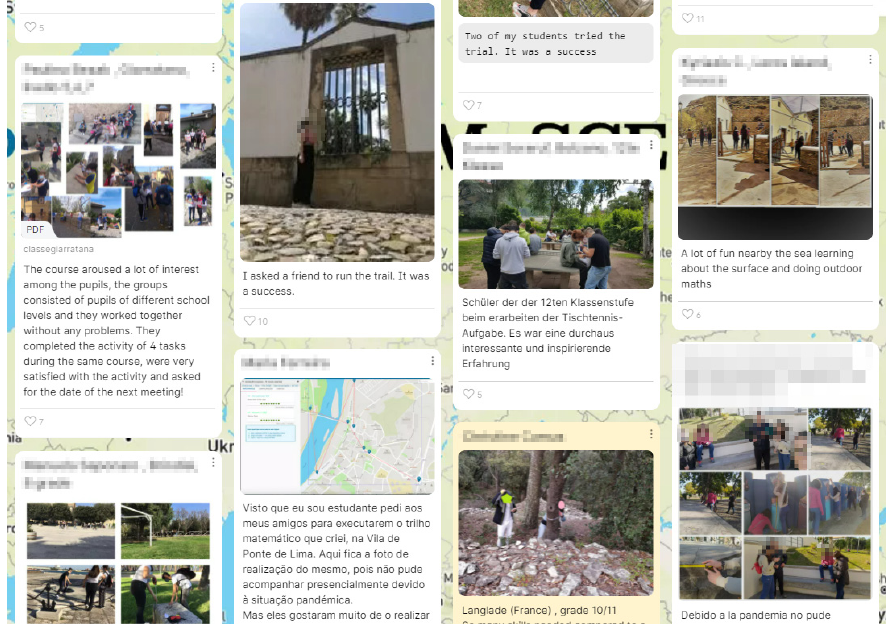
Figure 6. Snapshot of a padlet screen (screen 1 out of 11 pages) showing different levels of involvement.